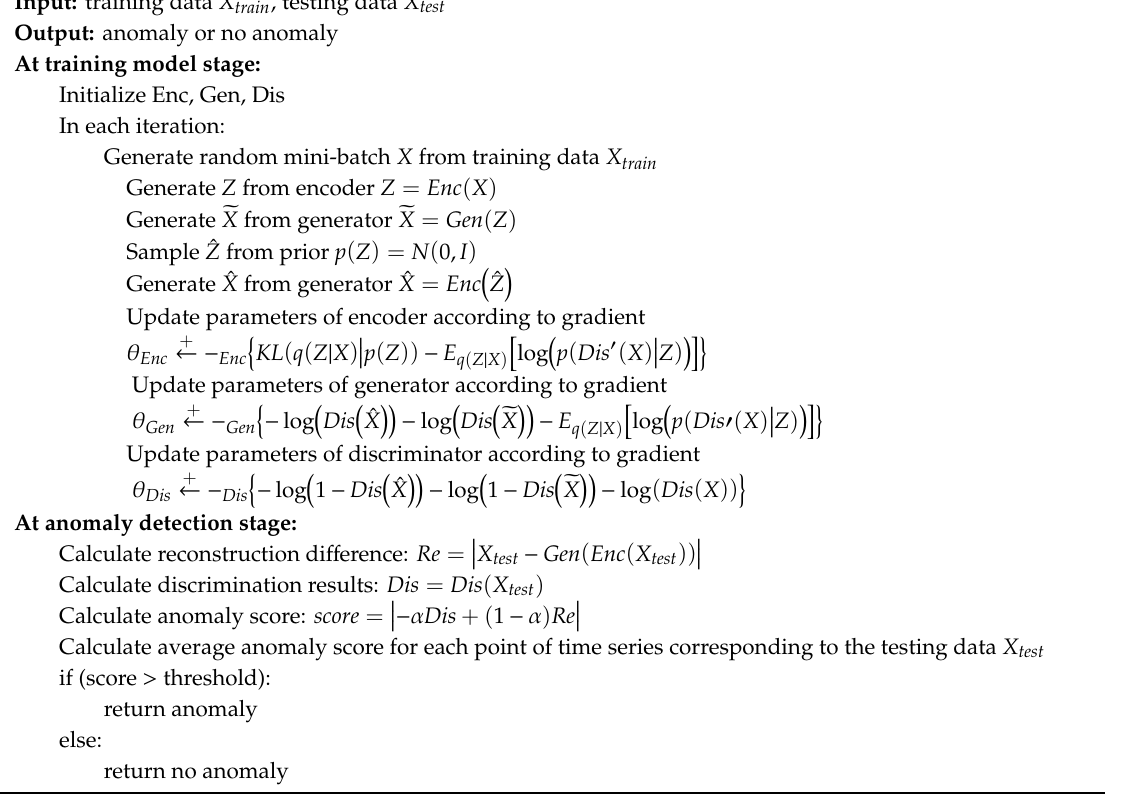
Algorithm 1. Anomaly detection algorithm used the LSTM-based